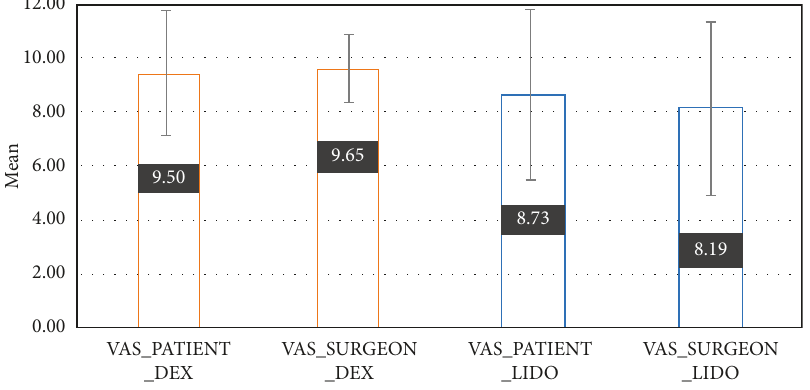
Figure 2: VAS scores of the patients and the surgeon.